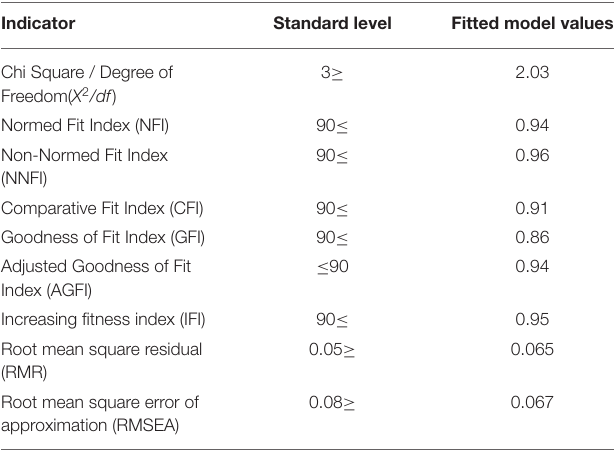
TABLE 4 | Standard values and fit indicators of social impact assessment